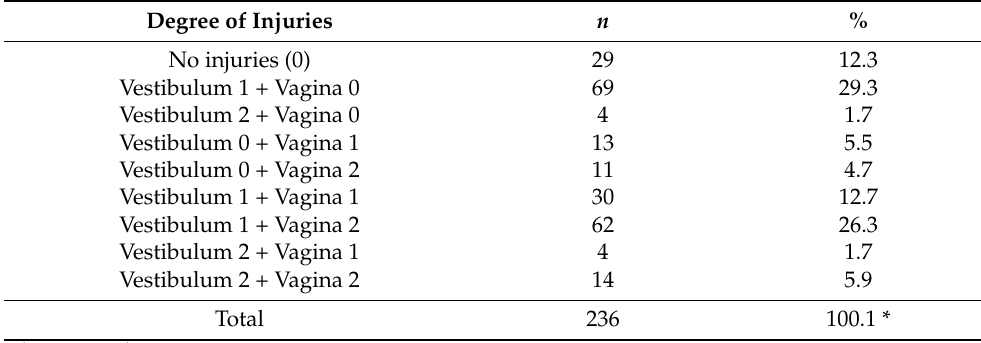
Table 1. Occurrence of the injuries of the vestibulum vaginae and vaginae ( n = 236). Degrees of injuries of the vestibulum vaginae: degree 0: no injuries; degree 1: marked injuries <2 cm deep; degree 2: severe injuries ≥ 2 cm deep; degrees of injuries of the vagina: degree 0: no injuries, degree 1: lesion <2 cm deep and up to 10 cm long; degree 2: lesion ≥ 2 cm deep and/or ≥ 10 cm long ( n = number of animals). Degree of Injuries n % No injuries (0) Vestibulum 1 + Vagina 0